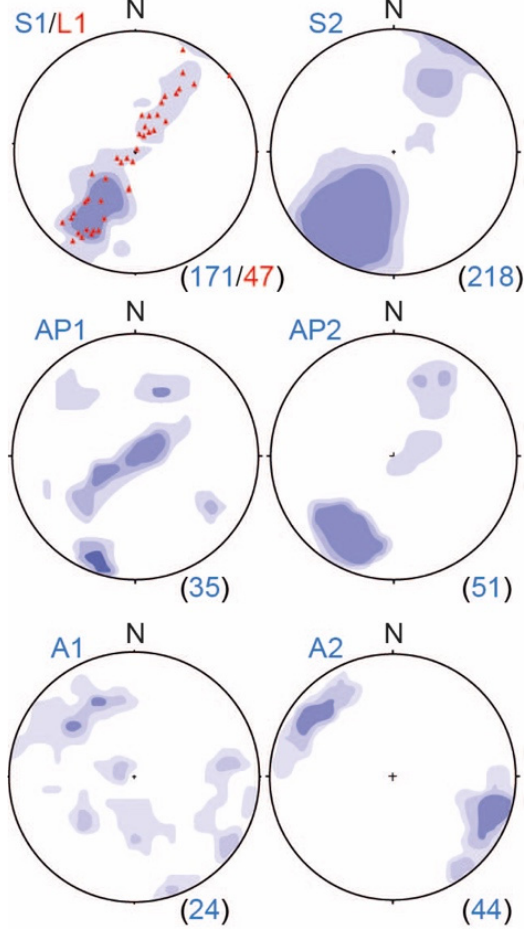
Figure 6. Stereonet of the D1 and D2 phase-related linear and planar structural features, lower hemisphere Schmidt equal area projection. S1: D1 phase tectonic foliation; L1: D1 phase mineralogical lineation; S2: D2 phase tectonic foliation; AP1: D1 phase axial plane; AP2: D2 phase axial plane; A1: D1 phase fold axes; A2: D2 phase fold axes.